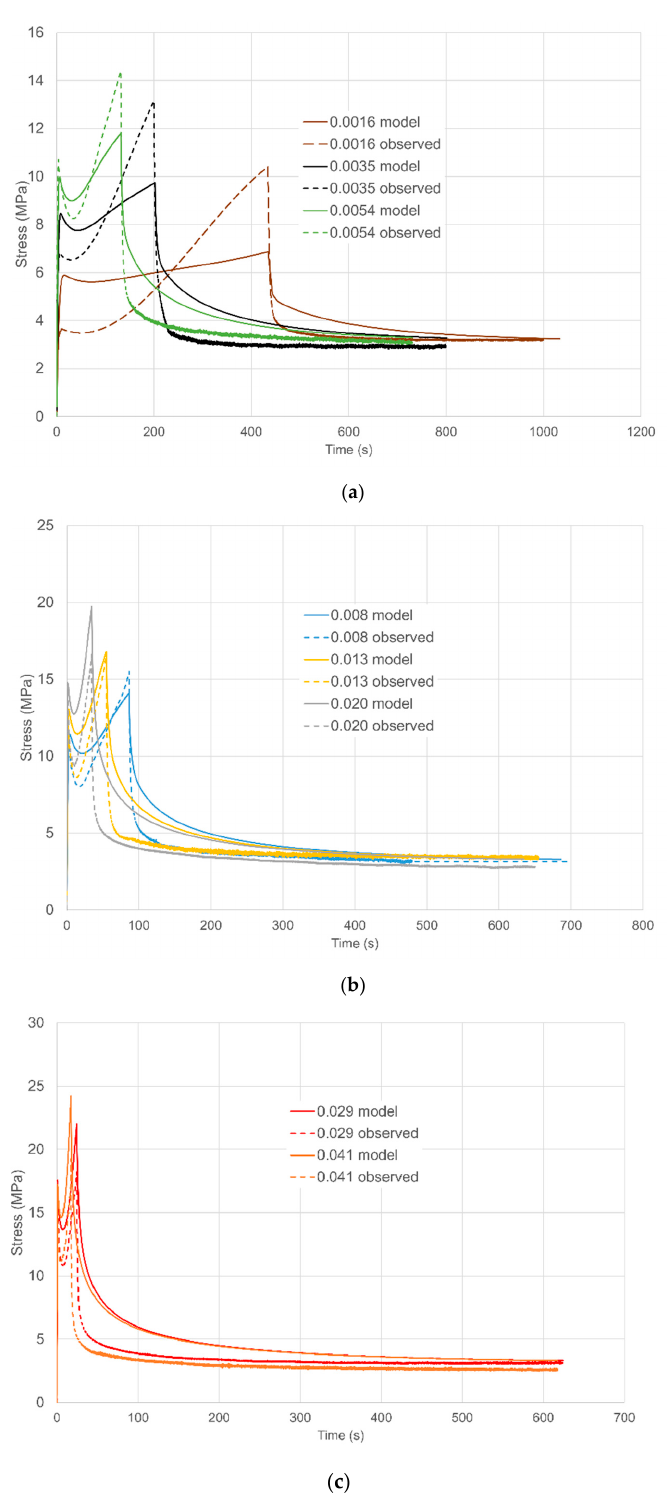
Figure 9. Uniaxial loading and stress relaxation. The key shows octahedral shear rates in s − 1 . ( a ) Three lowest strain rates; ( b ) three intermediate strain rates; ( c ) two highest strain rates. Figure 9b shows stress against time for the next three rates (8.0 × 10 − 3 –2.0 × 10 − 2 s -1 ) while the loading curves are included in Figure 10 as stress against strain for clarity. Pre- dictions are closer to observations at these rates. A major defect is the low predictions of stress drop; this is related to the value of Δ V s , which also controls the levels predicted for planar extensions. Similar comments apply to the highest rates (2.9 × 10 − 2 and 4.1 × 10 − 2 s − 1 ) in Figures 9c and 10.